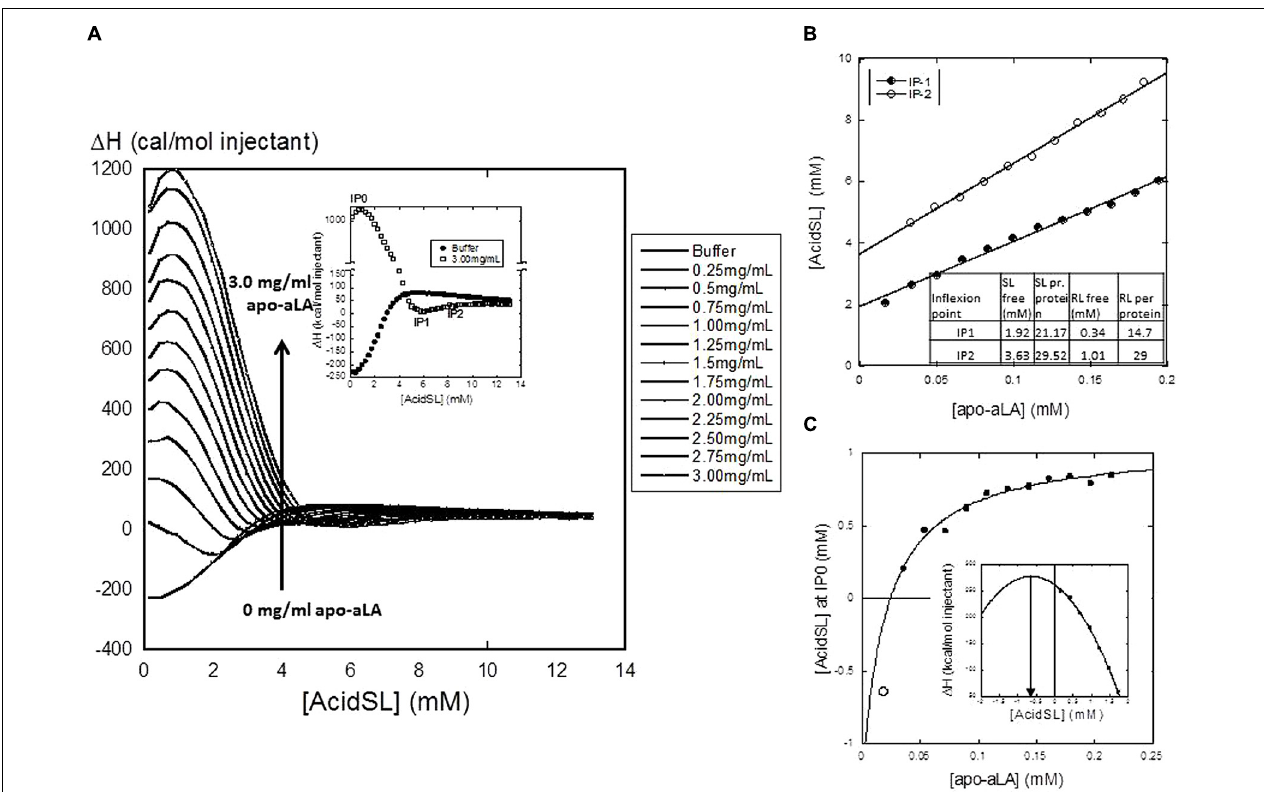
FIGURE 2 | (A) Isothermal Titration Calorimetry (ITC) titration of acidSL into apo-aLA, showing the enthalpograms resulting from titration into different concentrations of apo-aLA. Each data point represents the total enthalpy for a single injection event. The insert defines the characteristic points IP0-IP2. (B) Plot of IP1 and IP2 versus protein concentration. Results from the linear fits are provided in the insert Table. This yields the stoichiometry (number of acidSL molecules per apo-aLA molecule) as well as the free concentration of acidSL at the two characteristic points. (C) Plot of IP0 versus protein concentration fitted to a binding isotherm with floating base line using the data points indicated by the filled circles (Eq. 2). This intercepts the x -axis at 25 µ M apo-aLA and predicts an apparent dissociation constant of 20 ± 16 µ M apo-aLA, an amplitude of 2.4 ± mM AcidSL and an intercept of the y -axis at − 1.3 ± 1.2 mM AcidSL. The empty circle shows the negative peak position predicted for the ITC data obtained at 0.25 mg/ml apo-aLA (obtained from the parabolic fit shown in the insert). This point agrees well with the value predicted from the hyperbolic fit.